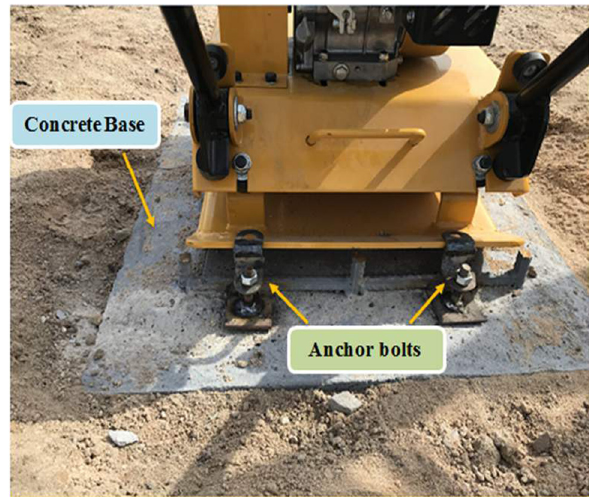
Figure 1: The source of vibration.